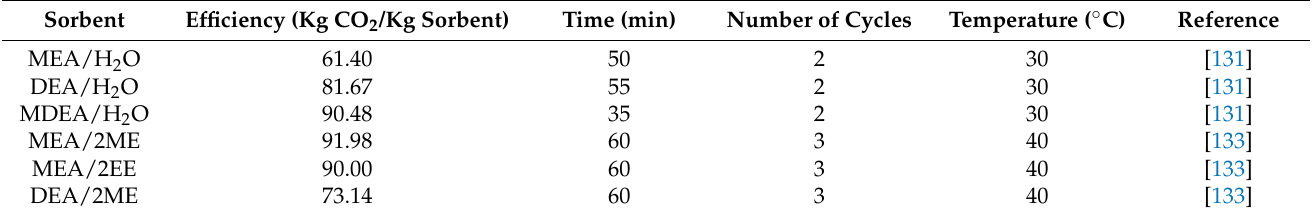
Table 4. Summary of the studies on amine-based sorbents